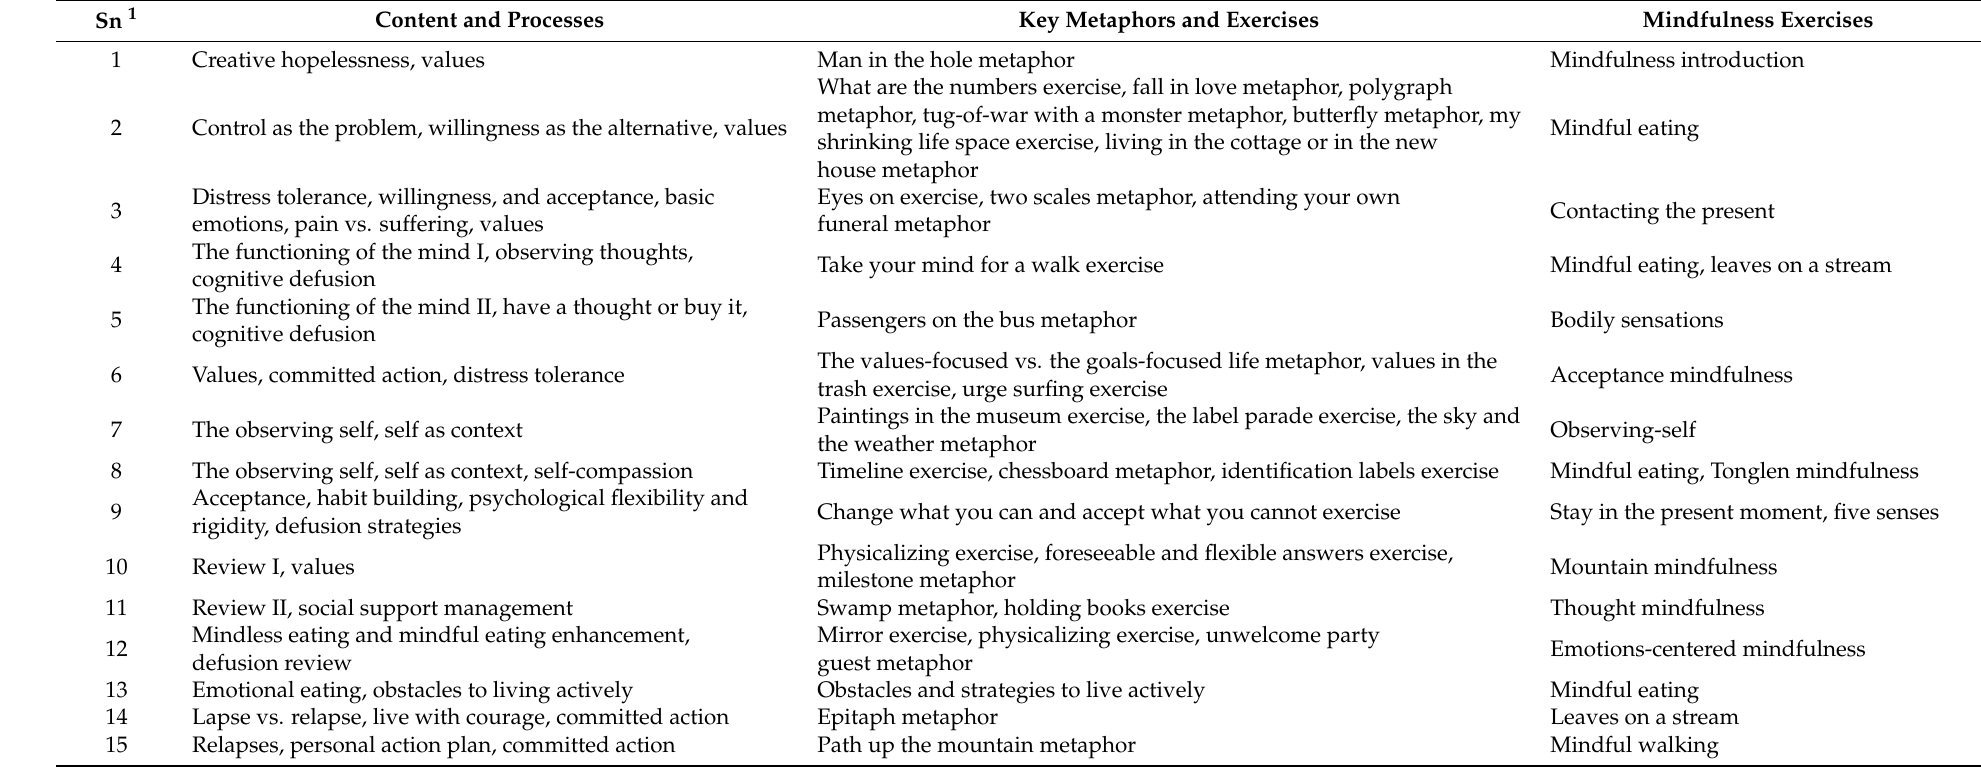
Table 2. Mind&Life intervention